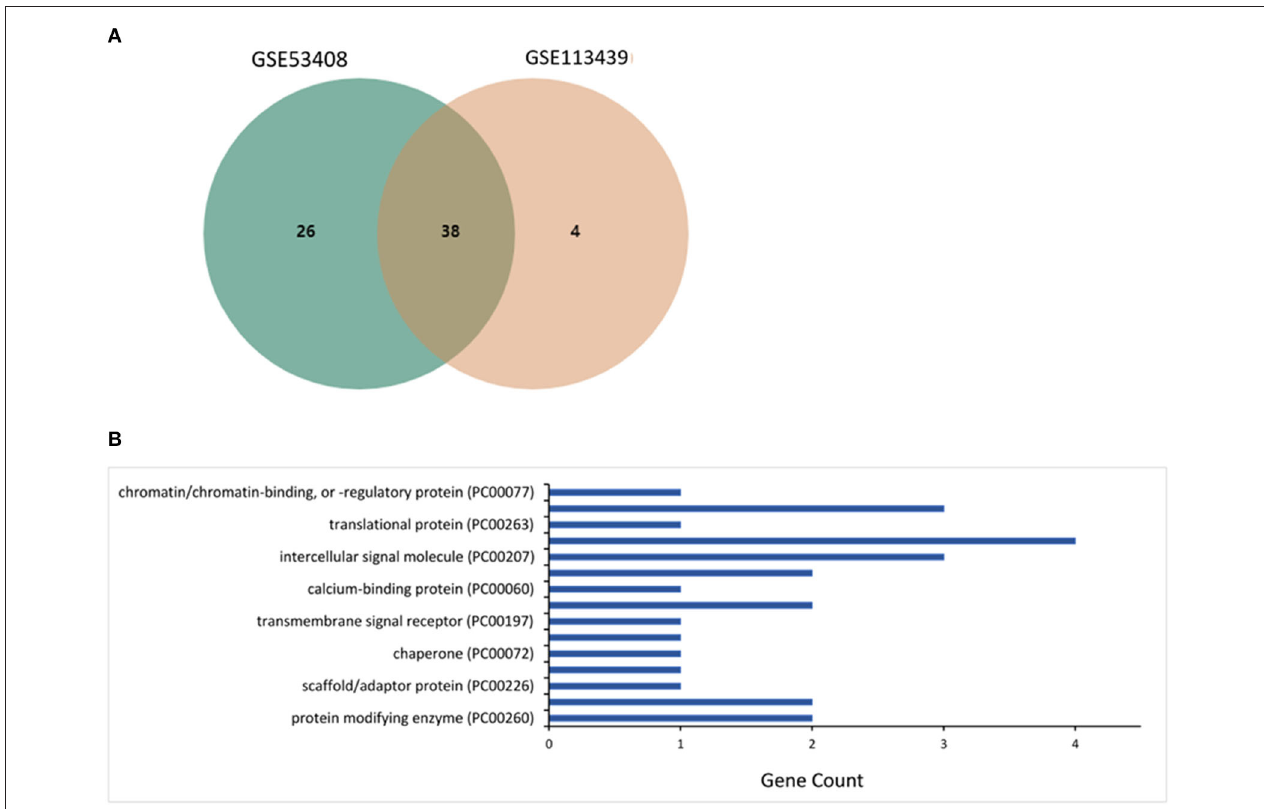
FIGURE 1 | Investigation of differentially expressed genes (DEGs) in microarray datasets GSE53408 and GSE113439. (A) The mutual core DEGs analyzed between two datasets. (B) The over-represented protein class coded by the DEGs estimated using the PANTHER database.